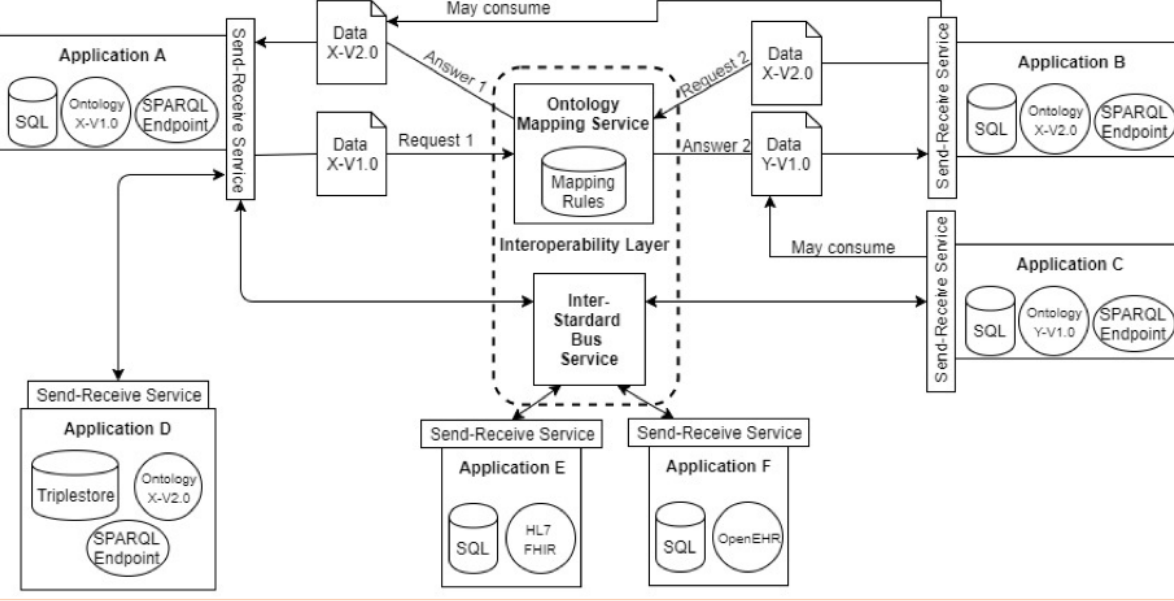
Figure 8. Architecture for interoperability between applications that use the Semantic Web and other standards (ie, HL7 FHIR and